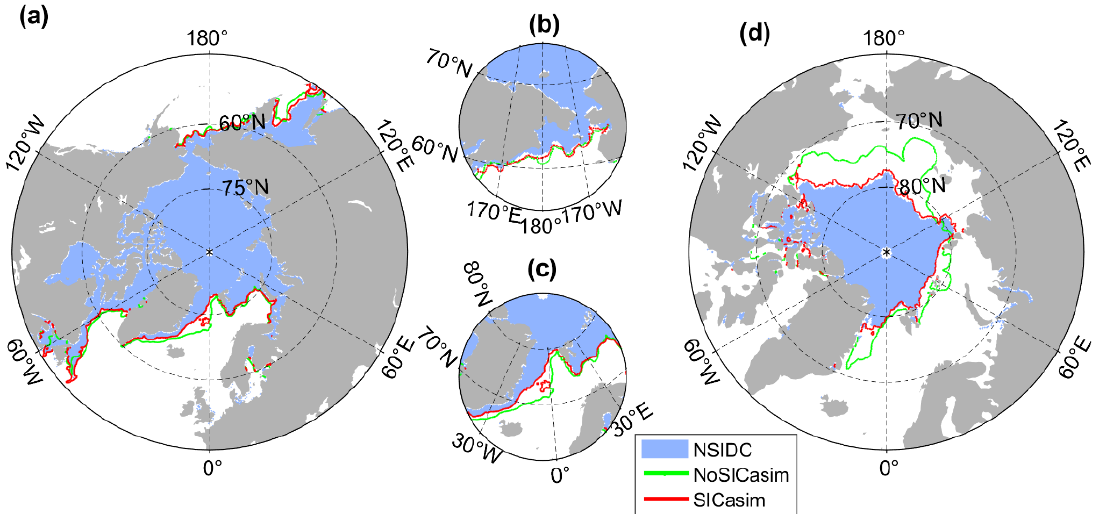
Figure 5. Simulated and observed sea ice edge locations in March ( a – c ) and September 2019 ( d ). Areas where sea ice concentration in the NSIDC observation is higher than 15% are denoted by the blue patch. The ice edges in the experiments NoSICasim and SICasim are denoted by green and red lines, respectively. Note that ( b , c ) show the same data as ( a ), but are zoomed in on the Bering Sea and the Nordic